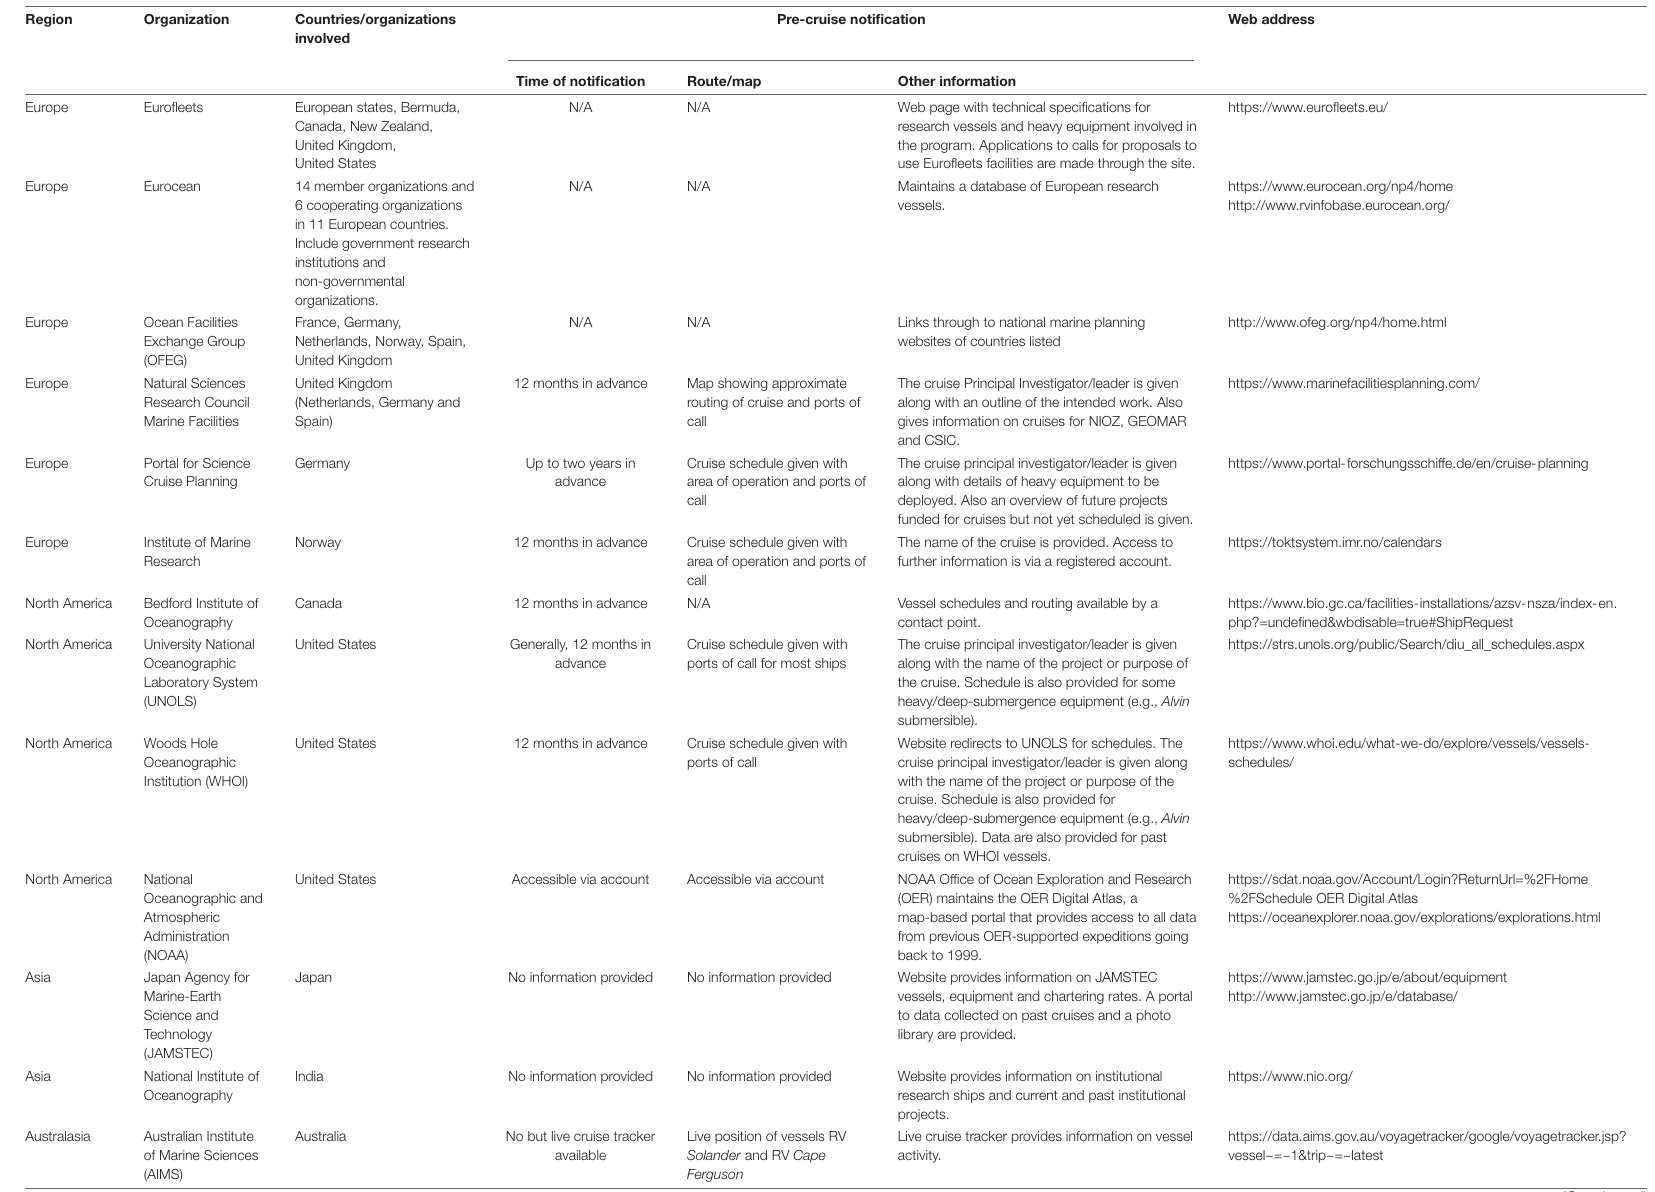
TABLE 1 | Pre-cruise notification practices at national and international level. Organisations which are involved in international cooperation on marine scientific research vessel operations are also included.